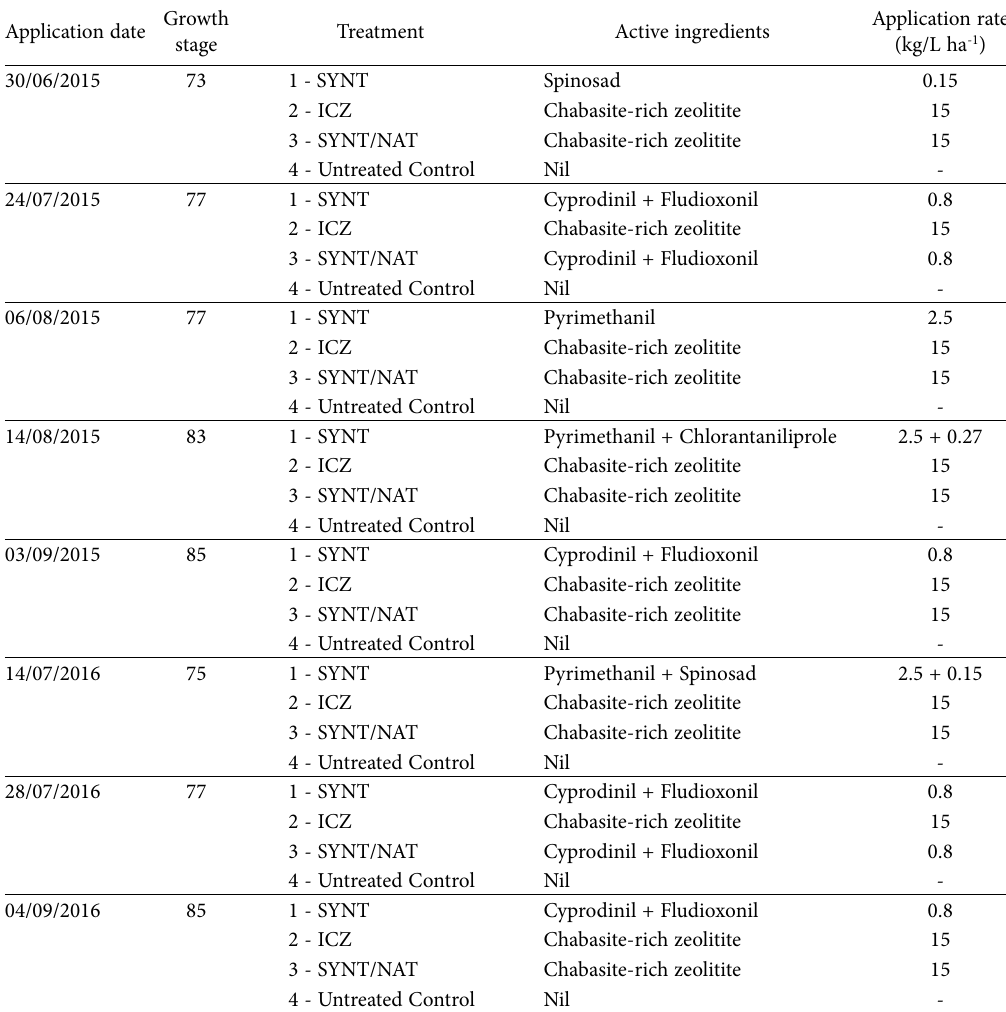
Table 1. Field applications against grey mould, sour rot and grapevine moth on cv. Montepulciano and Cococciola in the Ari vineyard in 2015 and